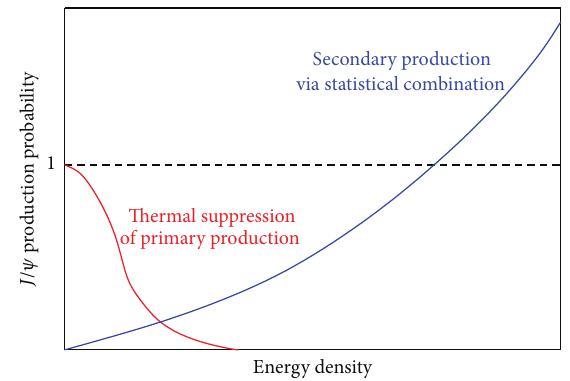
Figure 3: Schematic view of secondary production through statisti- cal